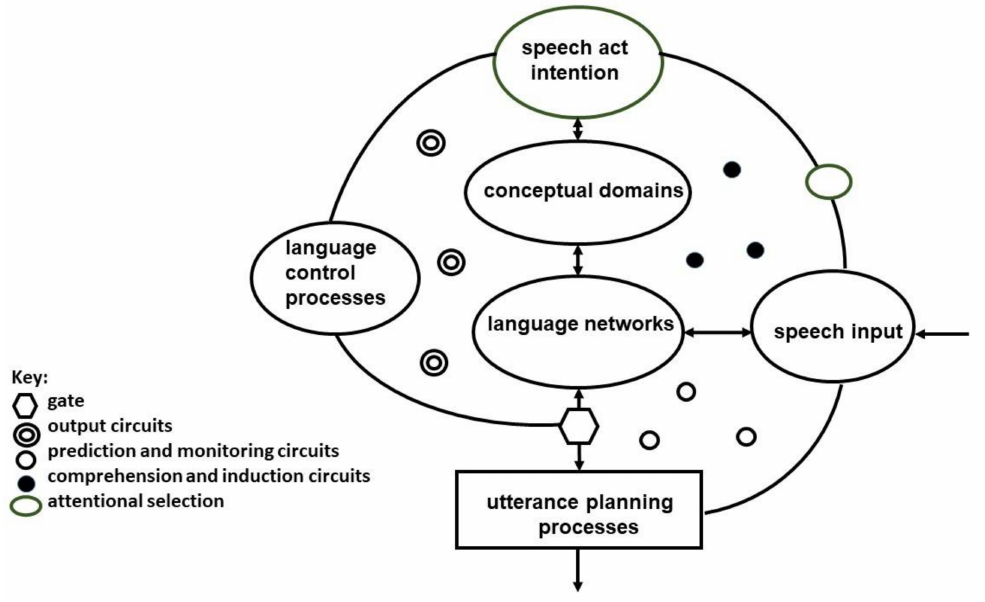
Figure 1. Schematic of the process of mapping a speech act into overt